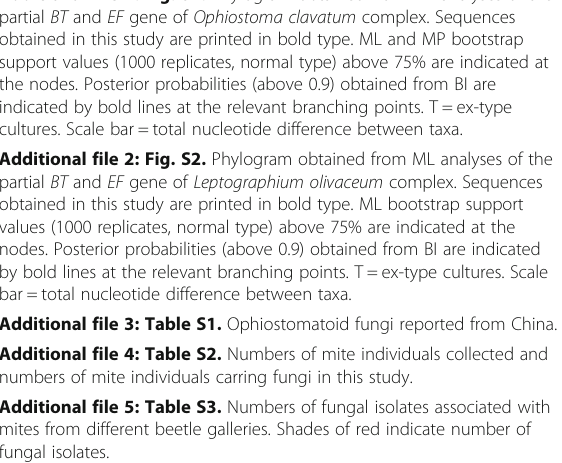
Additional file 3: Table S1. Ophiostomatoid fungi reported from China. Additional file 4: Table S2. Numbers of mite individuals collected and numbers of mite individuals carring fungi in this study. Additional file 5: Table S3. Numbers of fungal isolates associated with mites from different beetle galleries. Shades of red indicate number of fungal